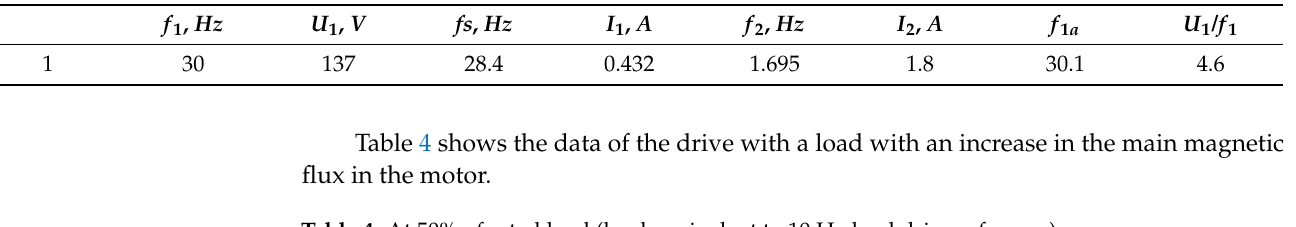
Table 4. At 50% of rated load (load equivalent to 10 Hz load drive